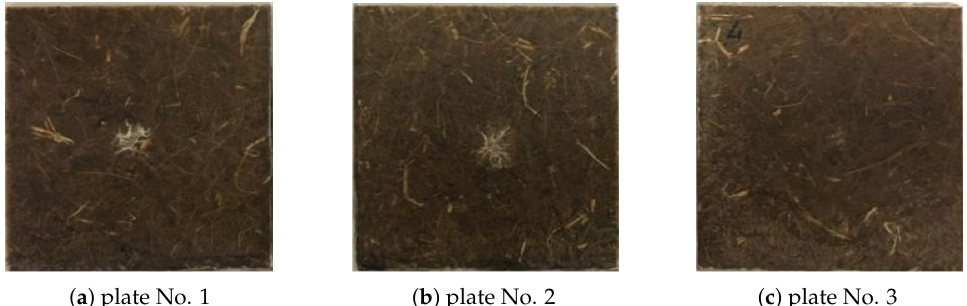
Figure 2. Photographs of the jute/hemp fiber hybrid specimens from the back side.